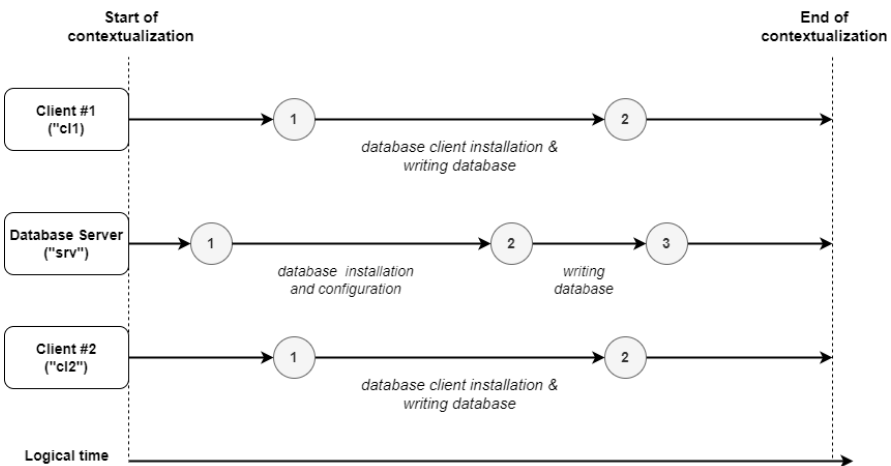
Figure 2. An example infrastructure containing three virtual